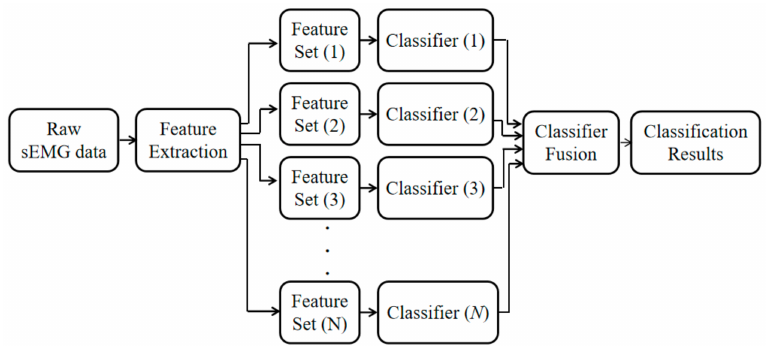
Figure 3. Flow diagram for the multiple classifier